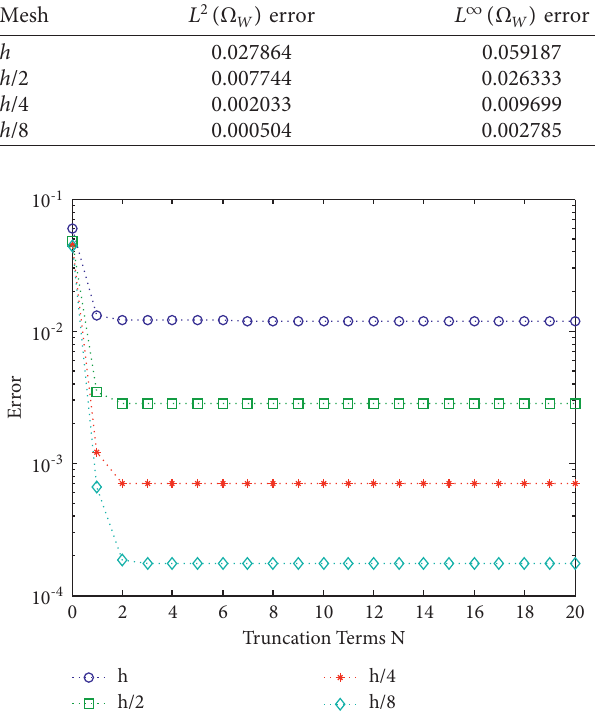
Figure 4: L ∞ ( Γ ) errors with different N ( d � 1 ) . E